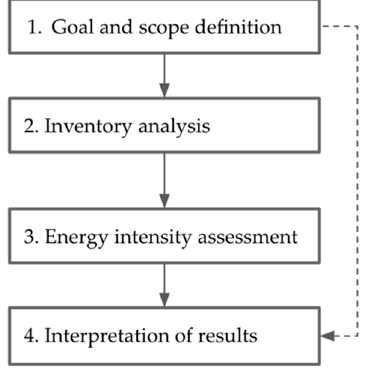
Figure 2. Methodology to assess the energy intensity.